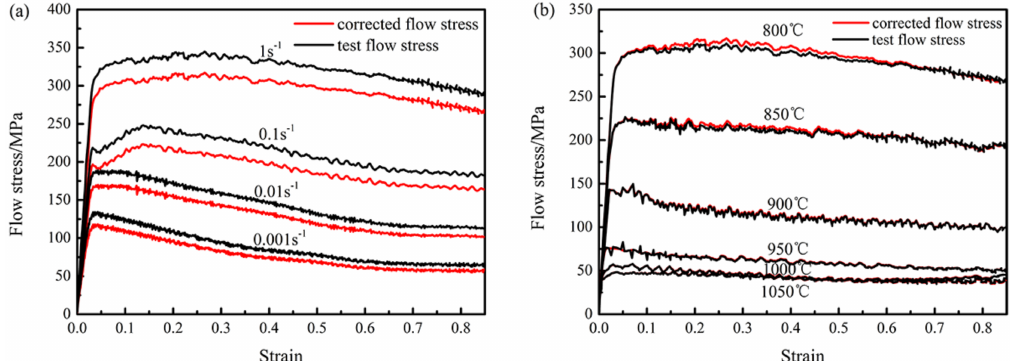
Figure 2. ( a ) Friction corrected flow stress curves of 800 ◦ C; ( b ) temperature corrected flow stress curves at strain rate of 1 s − 1